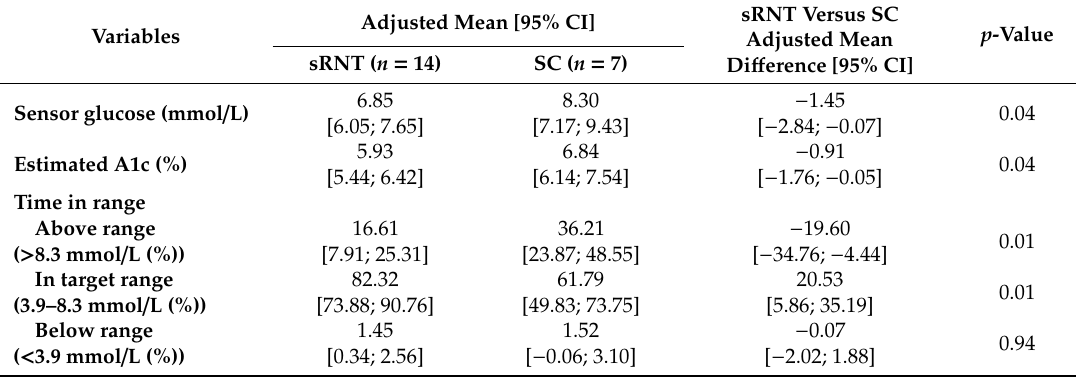
Table 4. Di ff erences in continuous glucose monitoring reading during Ramadan. between sRNT and SC ( n =